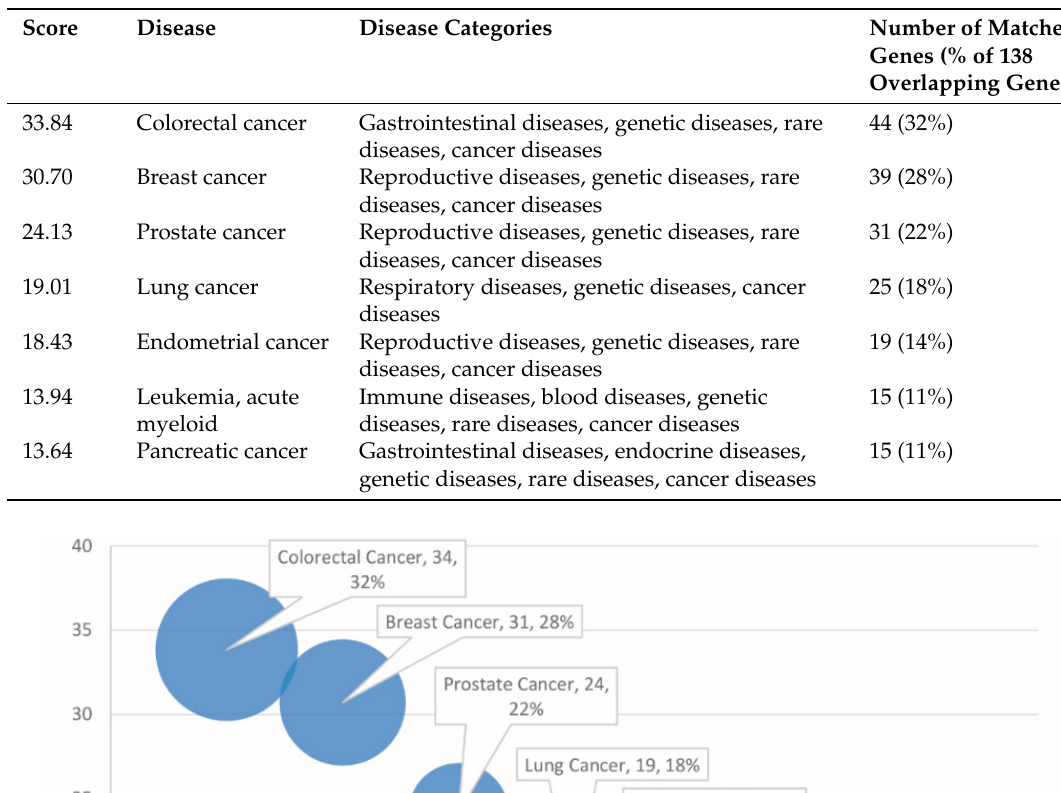
Table 1. Profiling of high scores in overlapping genes for autism and cancer-associated diseases.